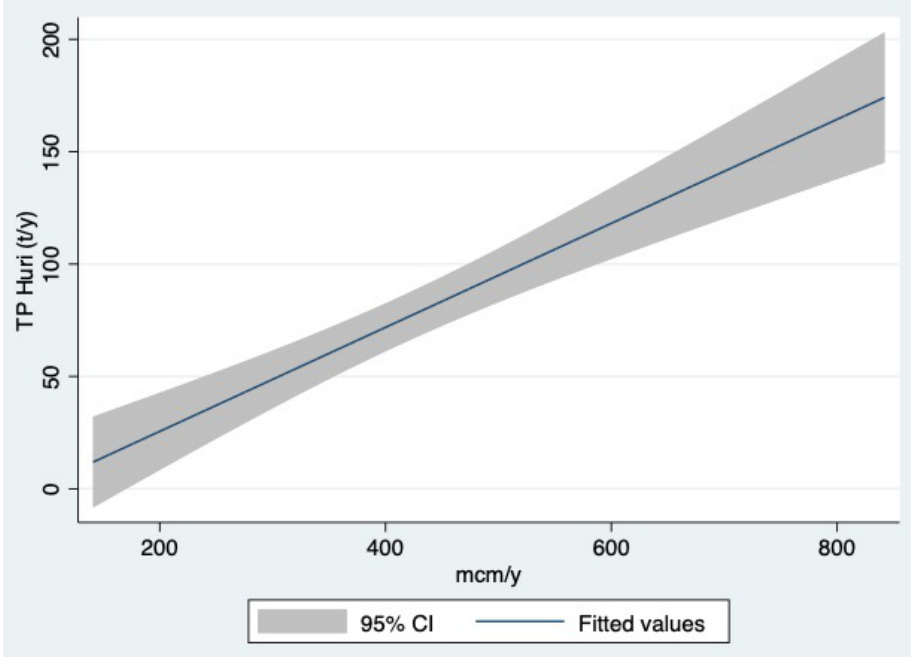
Figure 10. Linear prediction (95% CI) of annual TP loads (ton/y) in relation to the Jordan River discharge during 1970–2018.